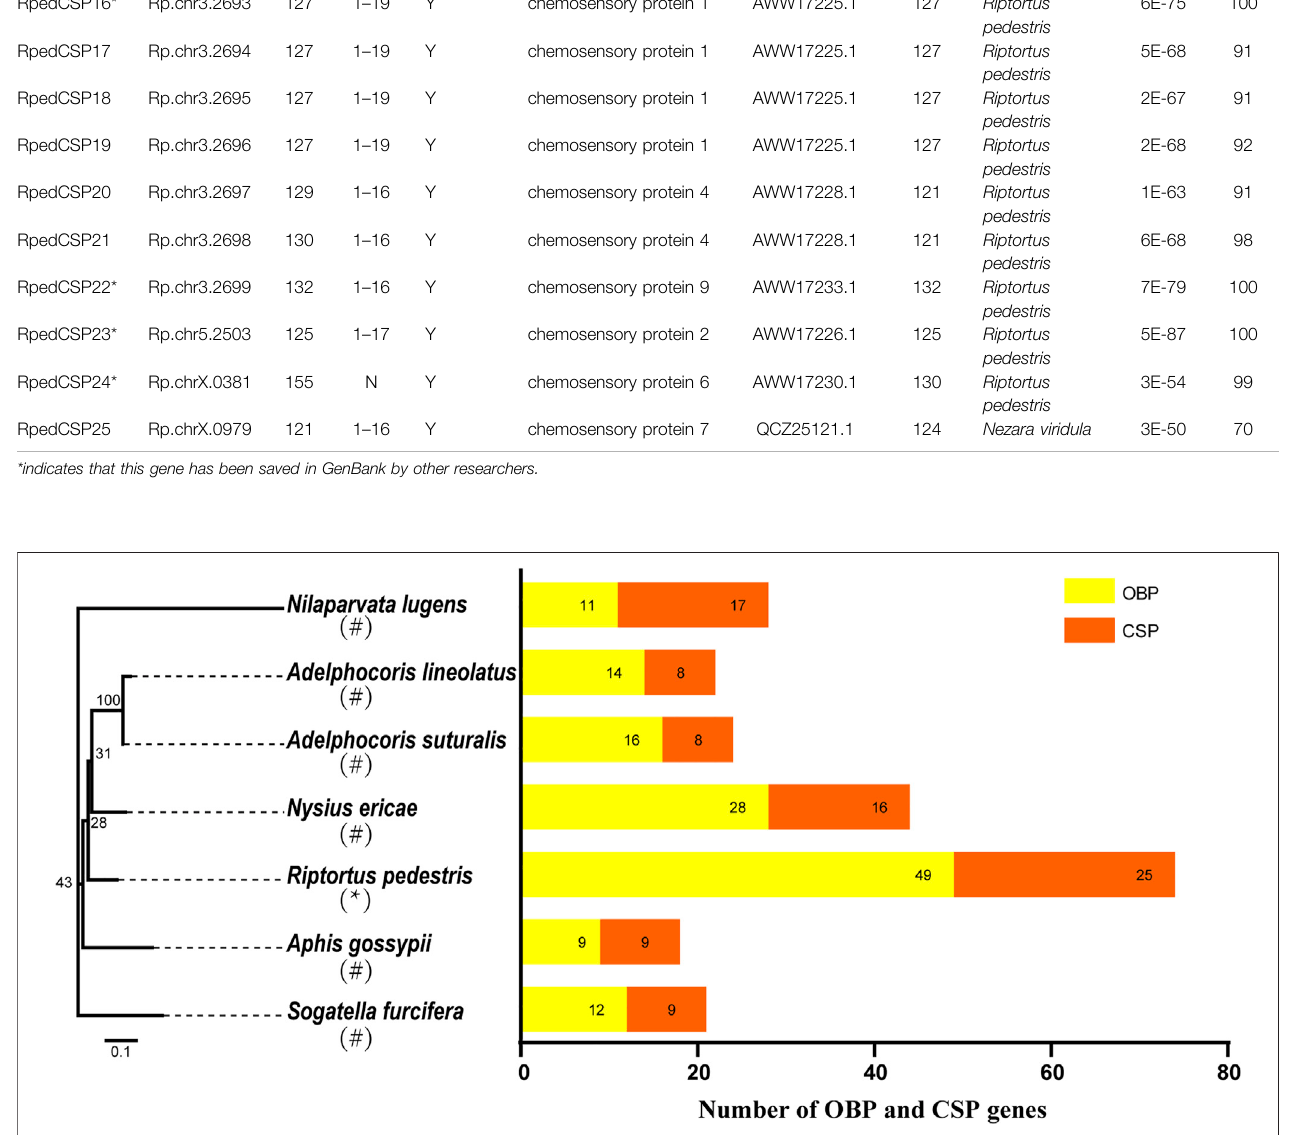
Frontiers in Physiology |